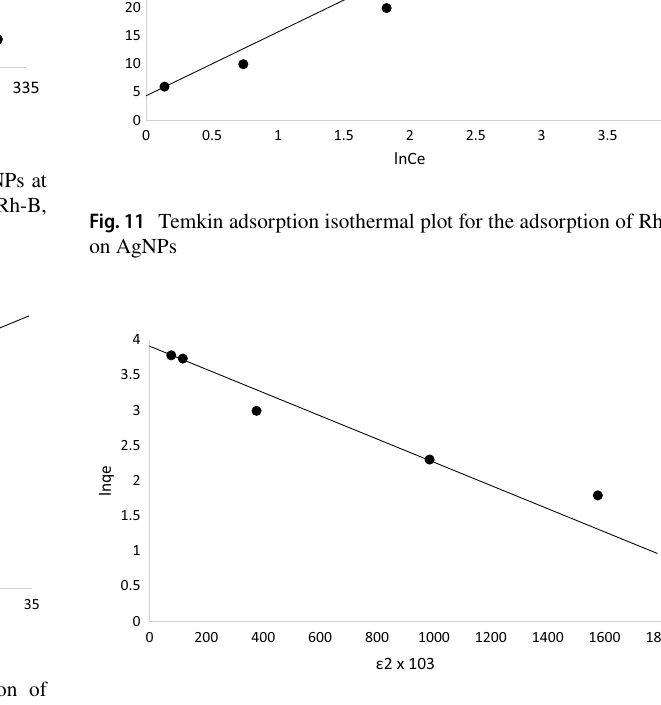
Fig. 12 Dubinin–Radushkevich adsorption isothermal plot for the adsorption of Rh-B on